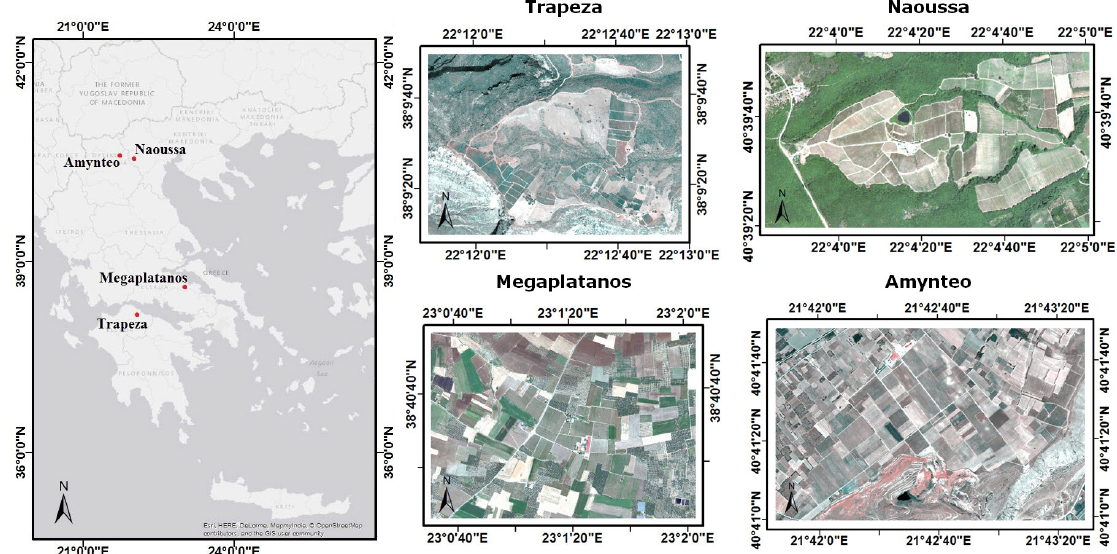
Figure 1. Data acquisition campaigns were conducted in four different viticulture regions in Greece, in Protected Geographical Indication ( PGI) zones. The campaigns were scheduled during the veraison period, conducted in 2012 and 2013, from late July to early